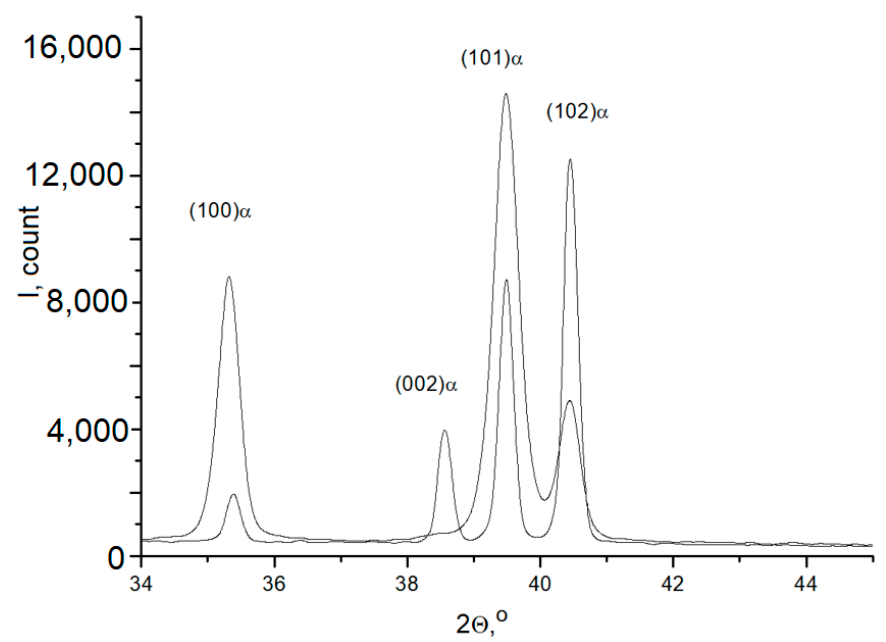
Figure 10. Merged X-ray diffractions from Figures 8 and 9.